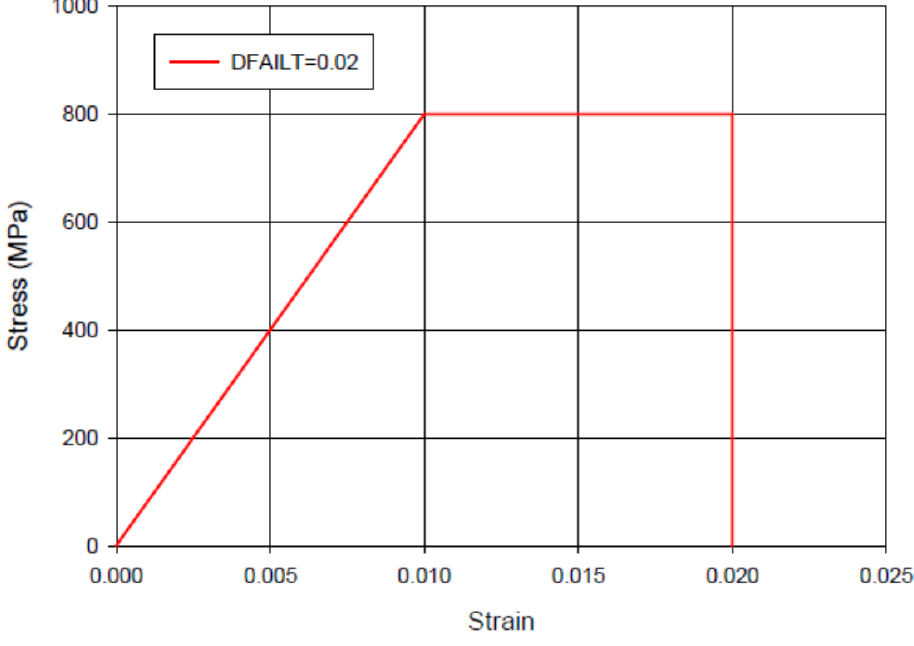
Figure 3. Stress – strain curve in fibre direction under tension, DFAILT = 0.02